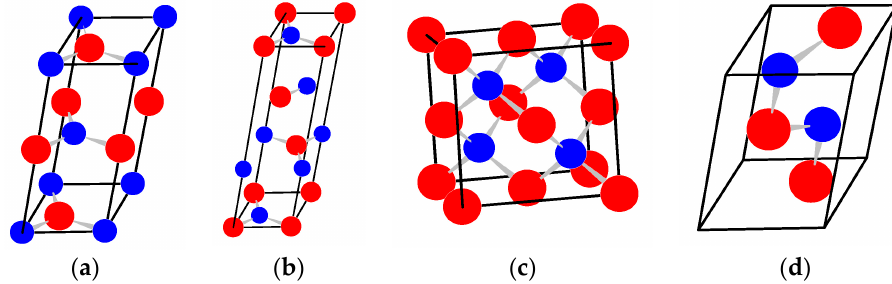
Figure 1. Crystal structures of BN polymorphs: ( a , b ) graphite-like hexagonal (hBN, 2H) and rhombohedral (rBN, 3R) low-density BN polytypes; and ( c , d ) cubic/sphalerite (cBN, 3C) and hexagonal/wurtzite (wBN, 2H) dense BN polytypes. The crystallographic axes are oriented in traditional way ( u x × u y || u z ), and the coordinate origin (0; 0; 0) is in the front-left-bottom corner.